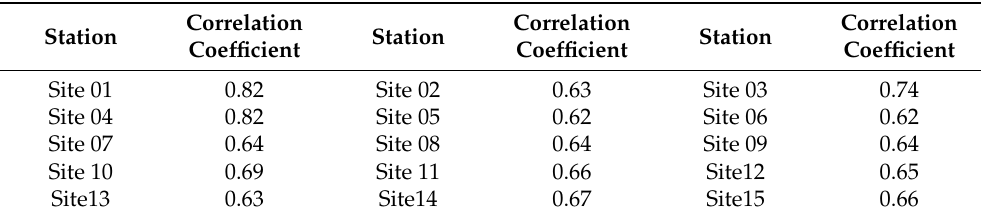
Figure 12. Comparison between CORS-based GWSA and groundwater monitoring results. Table 8. Correlation coefficients between CORS-based GWSA and observed GWSA at groundwater monitoring stations.